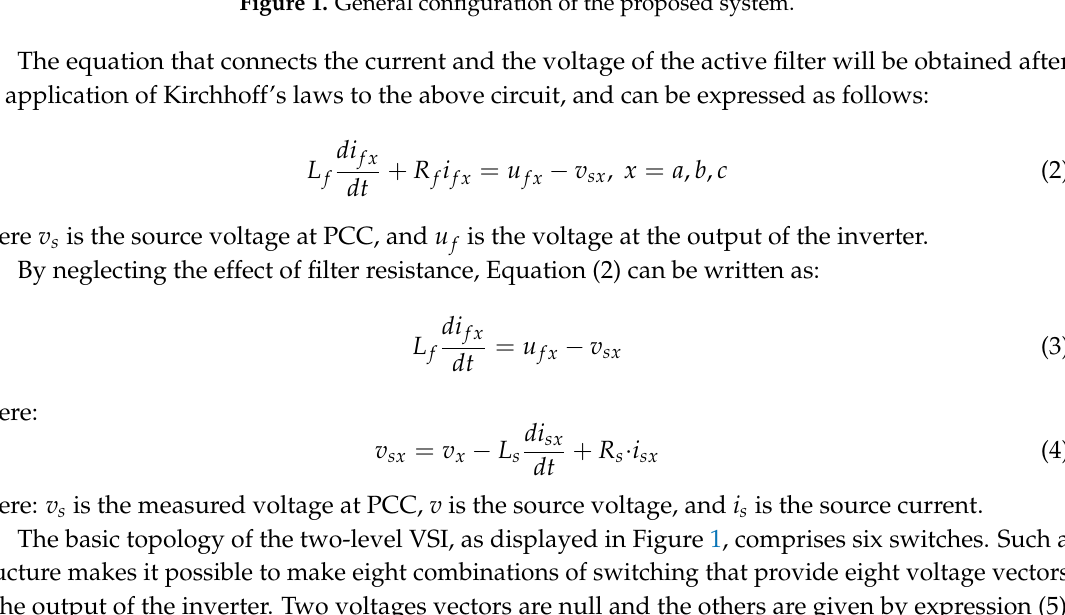
Figure 1. General configuration of the proposed system.